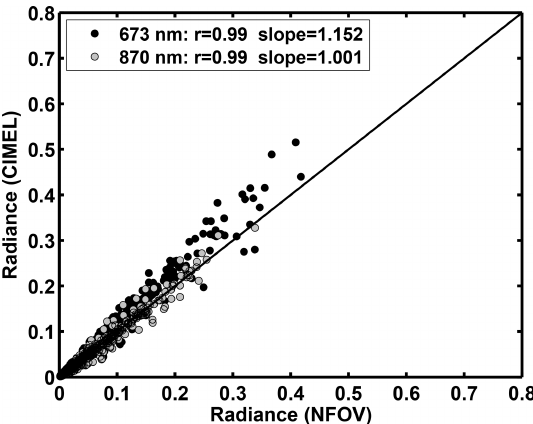
Figure 1. CIMEL sun-photometer-measured radiance as a function of narrow-field-of-view (NFOV) radiometer-measured radiance at 673nm (black dots) and 870nm (gray dots). The diagonal line rep- resents the 1 : 1 line. Units are watts per steradian per squared me- ter (Wsr − 1 m − 2 ). The legend gives the coefficient of correlation ( r ) and the slope of the best-fit linear regression line through each